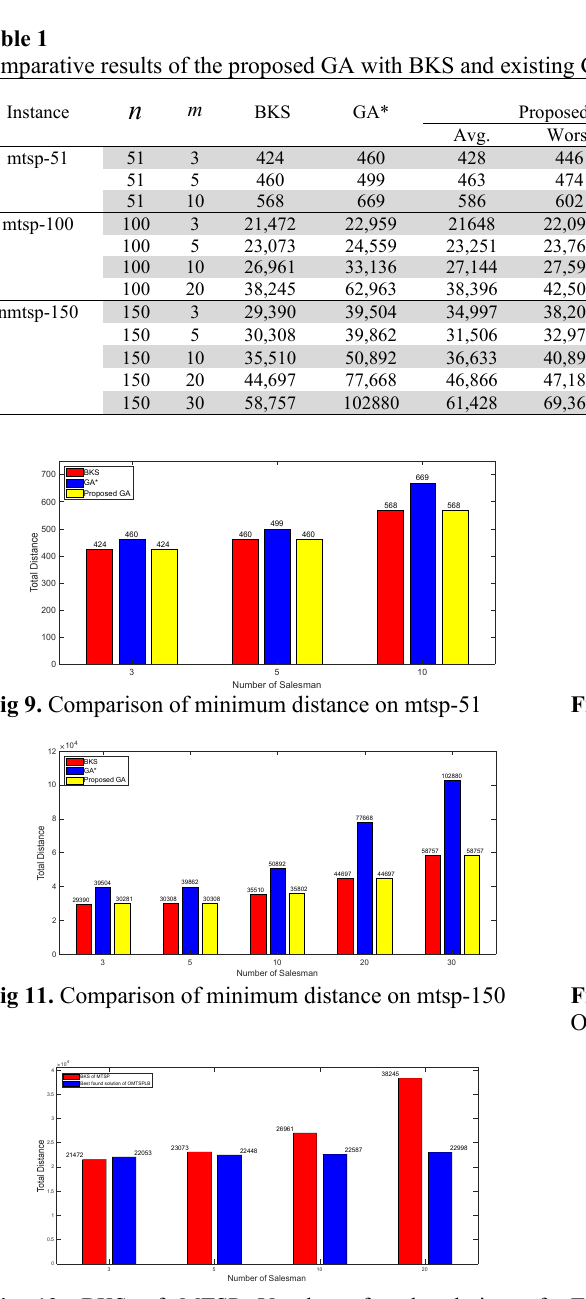
Fig 14. BKS of MTSP Vs. best found